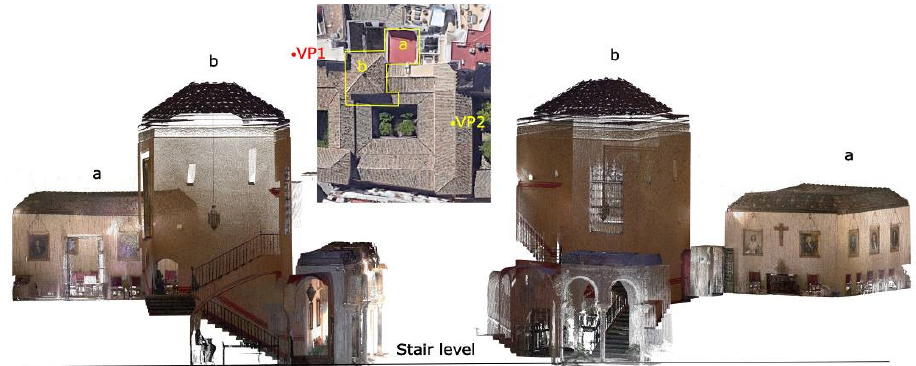
Figure 12. 3D orthographic views extracted from the point cloud to better understand the different levels for the mezzanine ( a ) and the tower above the staircase ( b ). Central image shows the polygonal sections (yellow) and the viewpoints VP1 and VP2; the left image was observed from VP1 and the right image was observed from VP2.